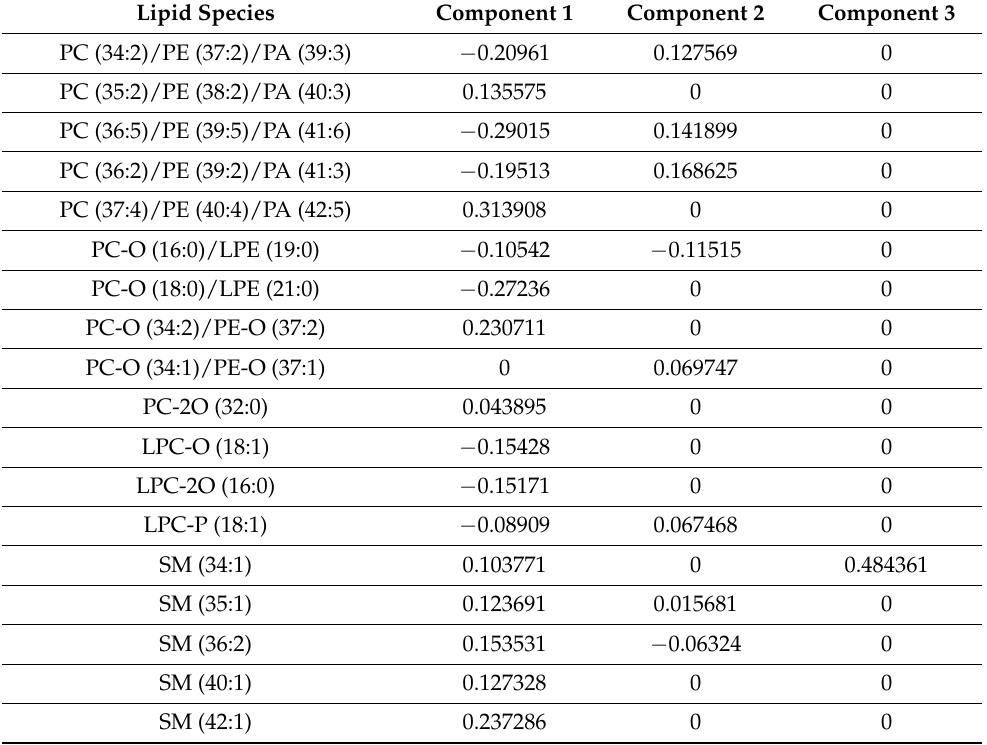
Figure 4. Scatter plot showing the sPLS-DA model and its prediction for Mild cases and Moderate–severe at S3. The x axis represents Component 1 and the y axis represents Component 2. Table 6. sPLS-DA loading values for Mild HIE cases vs. Moderate–severe HIE Cases at